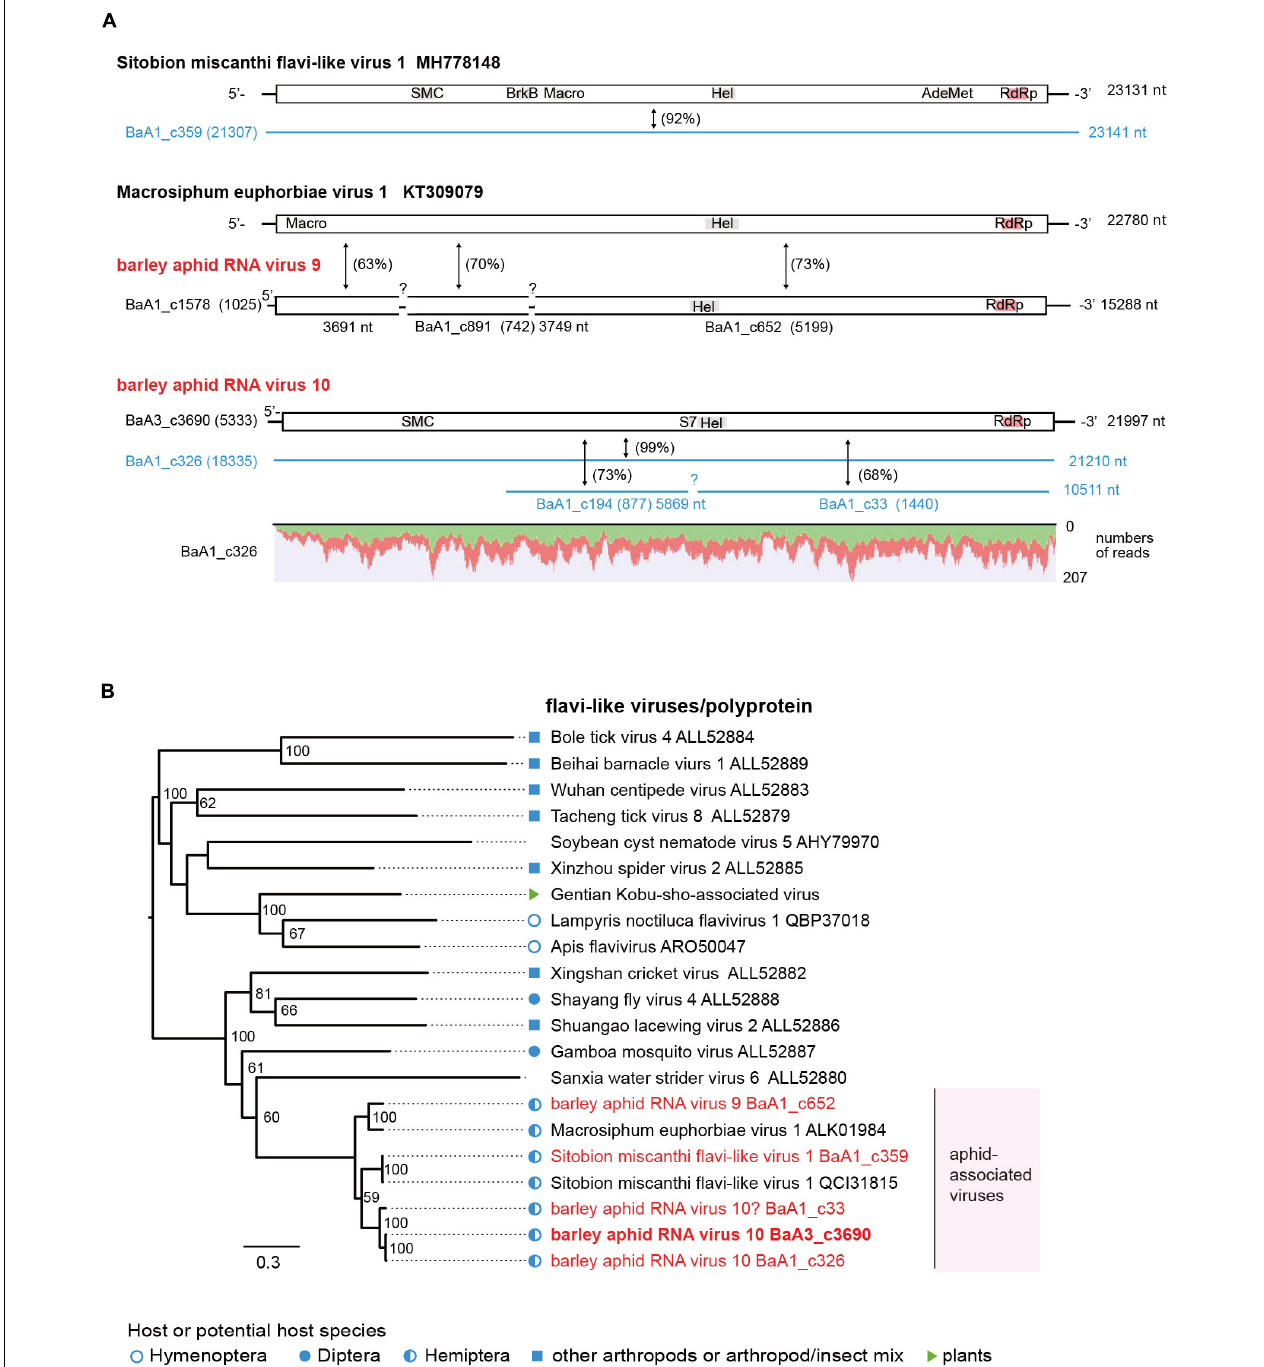
FIGURE 4 | Genome organizations and phylogenetic relationships of flavi-like viruses. (A) The genome structures of flavi-like viruses, Sitobion miscanthi flavi-like virus 1, Macrosiphum euphorbiae virus 1, and two novel flavi-like viruses (named barley aphid RNA virus 9 and 10, BARV-9 and -10) from Rhopalosiphum padi, R. maidis , and Sitobion avenae . Conserved domains for viral polyproteins or other proteins are shown as gray or red highlights within the ORFs (Macro domain, a high-affinity ADP-ribose binding module; SMC super family, chromosome segregation ATPase; BrkB, This family may act as a virulence factor; S7, Flavivirus NS3 serine protease; HEL, RNA helicase; AdoMet, S-adenosylmethionine-dependent methyltransferases; RdRp, RNA-dependent RNA polymerase). Virus-like contigs derived from this study are represented as black bars or blue lines and other information is the same as shown in Figure 2 . Read depth coverage throughout the assembled virus contig is shown below the schematic structure of the viral genome. (B) Phylogenetic relationships of flavi-like viruses. The ML phylogenetic tree was constructed using a multiple amino acid sequence alignment of the polyprotein or its candidate sequences. The scale bar represents amino acid distances. The numbers at the nodes are bootstrap values of >